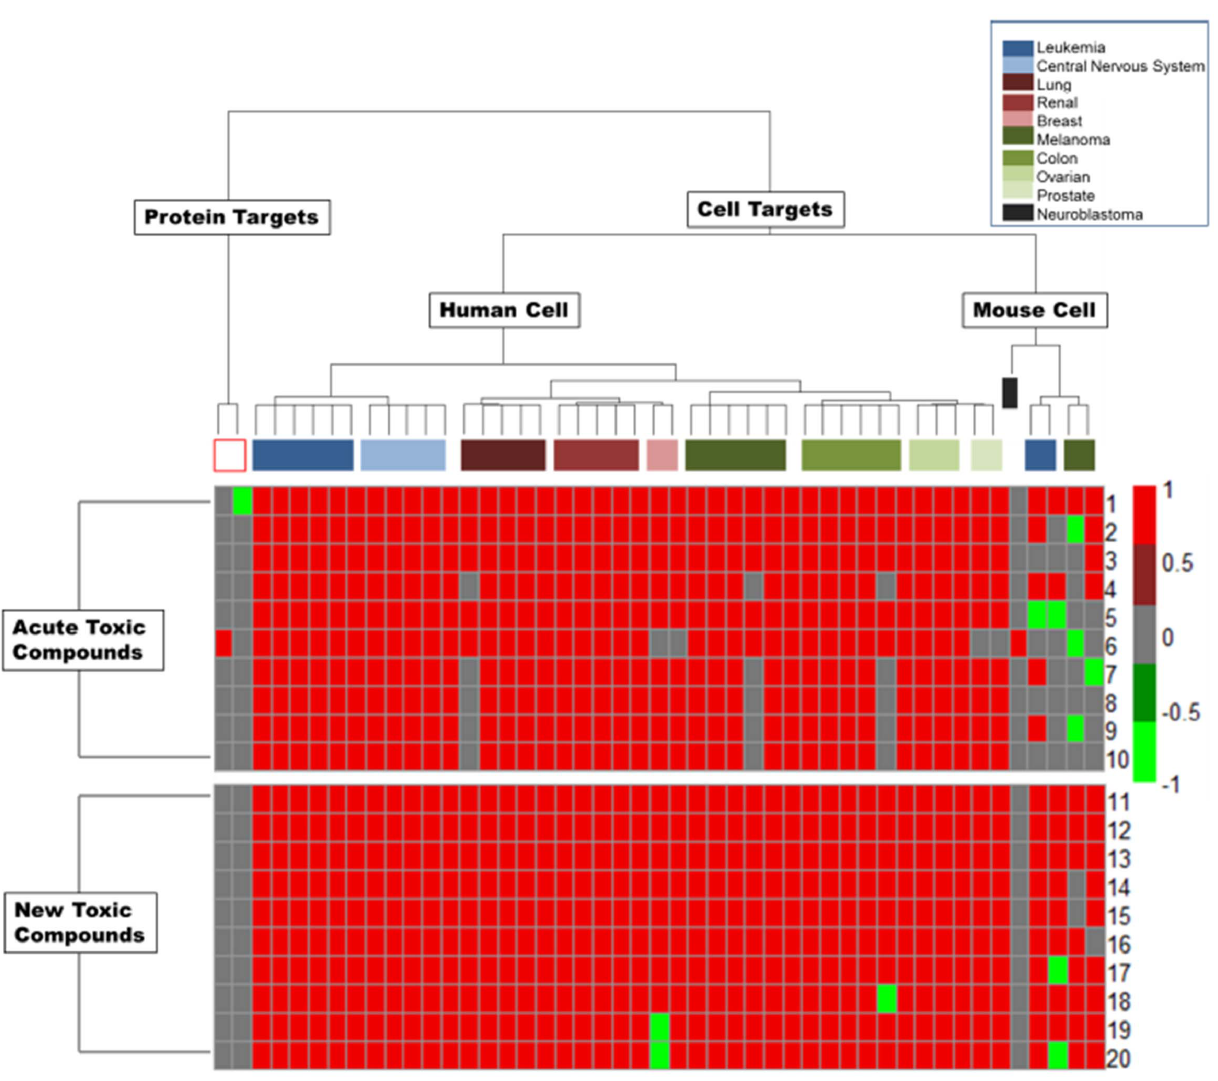
Figure 7. The heatmap of 10 top-ranked acute toxicity compounds (from 1–10) along with 10 top-ranked new PubChem compounds (from 11–20). All the compounds were ranked based on the S values of their biological responses in 47 bioassays identified in this study.